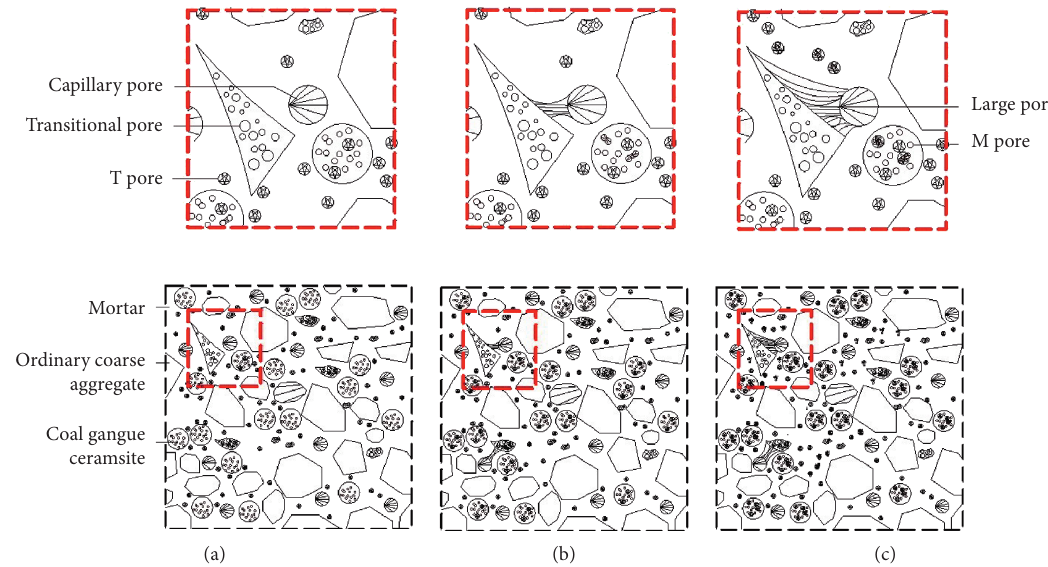
Figure 13: Schematic diagram of internal variation of coal gangue ceramsite concrete